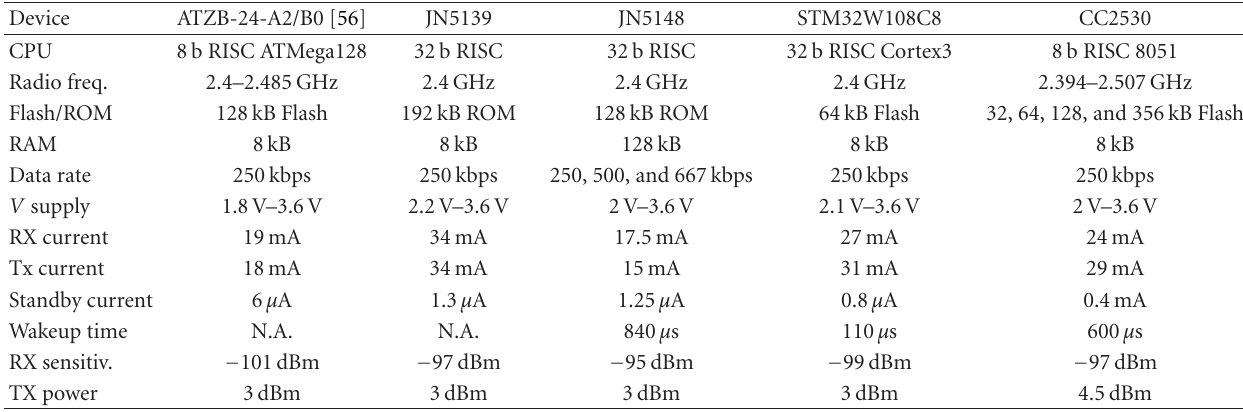
Table 4: COTS components to implement the energy HAN